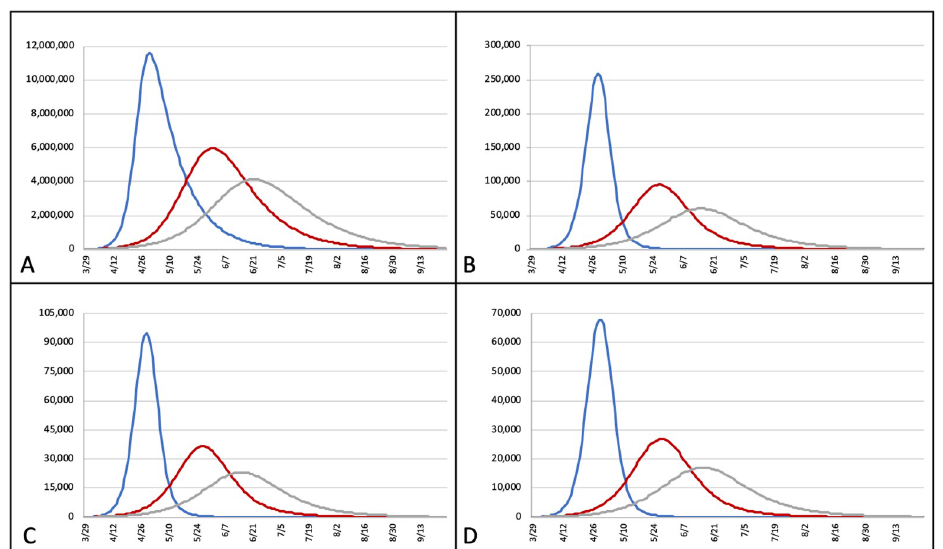
Fig 1. Projected number of active cases (A), hospital bed occupancy (B), ICU bed occupancy (C), and ventilator utilization (D) by date with 0% (blue), 50% (red), and 60% (grey) mitigation scenarios. X-axis = date; Y- axis = number of infected individuals (A), hospital beds (B), ICU beds (C), and ventilators